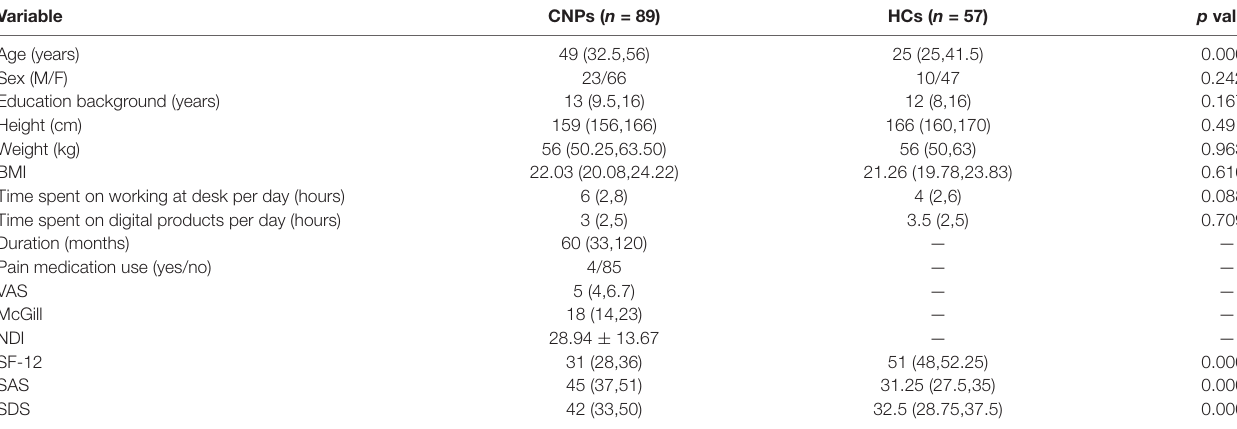
TABLE 1 | Demographic characteristics of subjects.